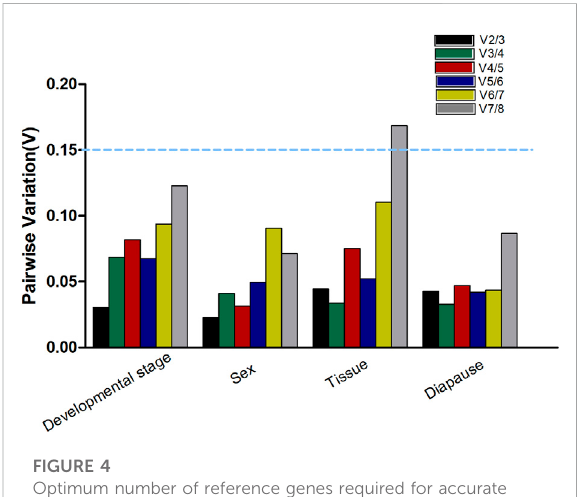
FIGURE 4 Optimum number of reference genes required for accurate normalization of gene expression. Pairwise variation (V) values in the four groups using